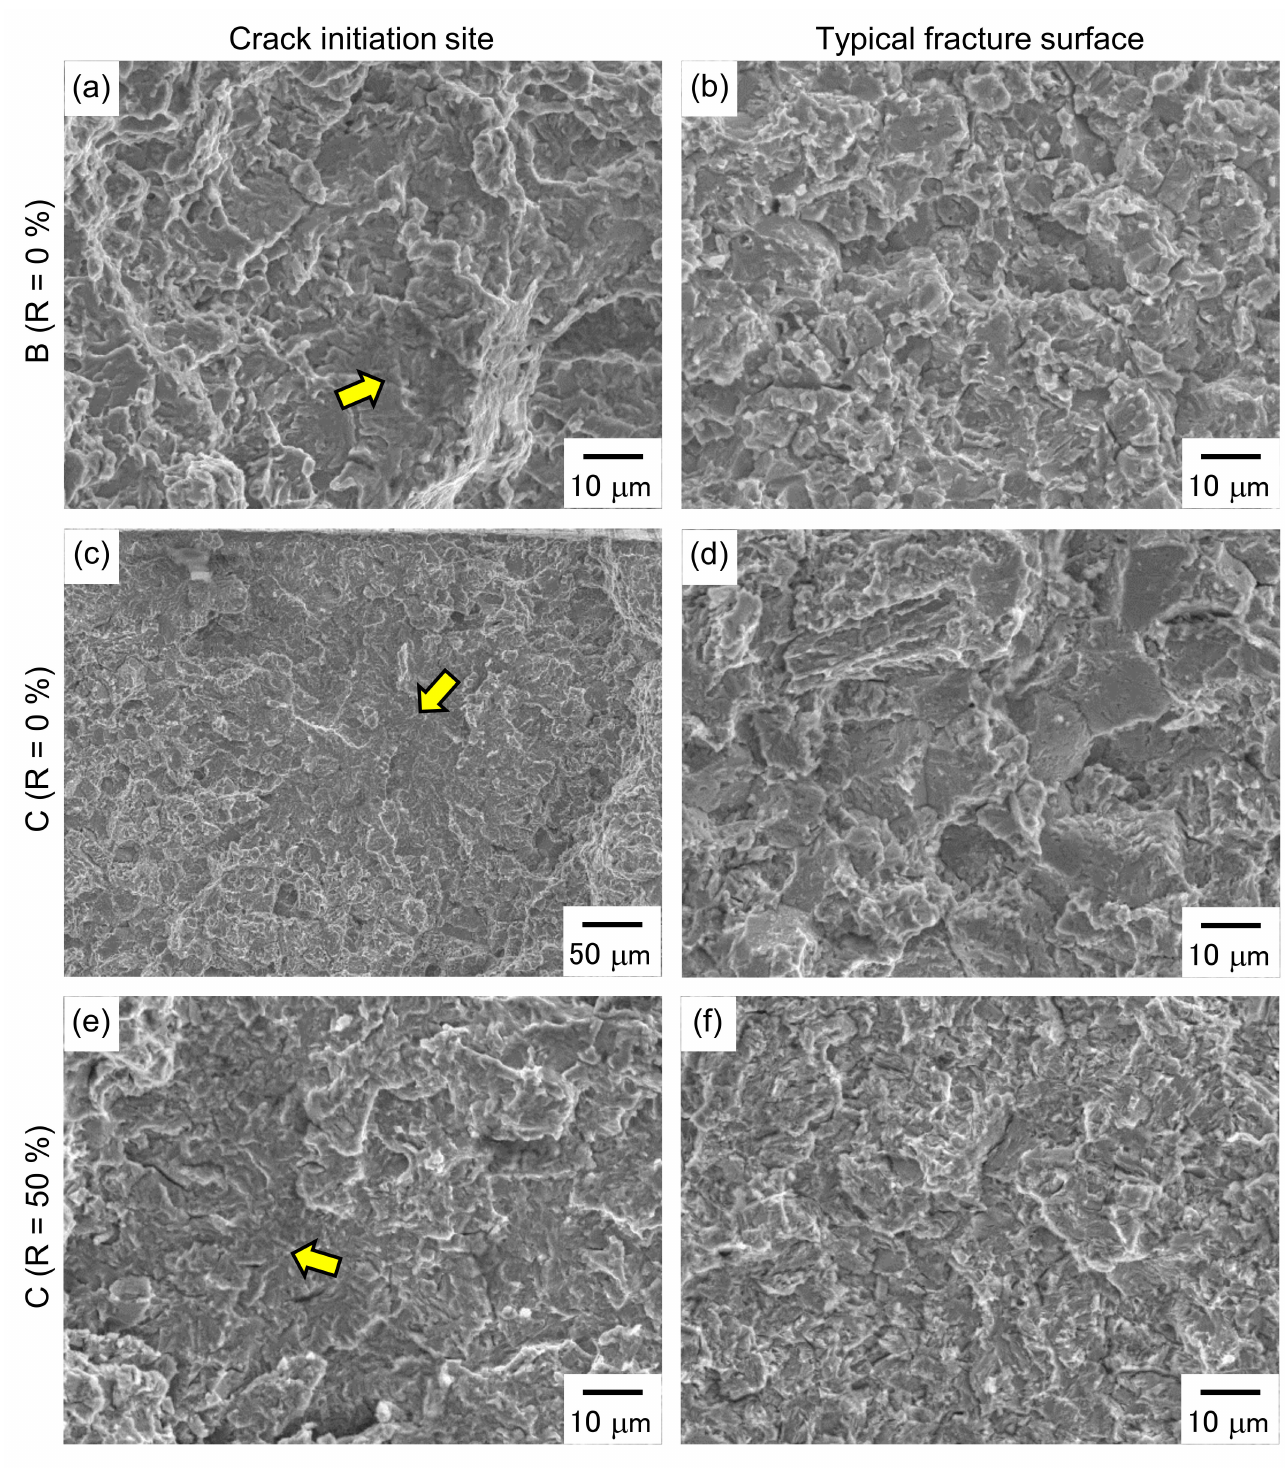
Figure 10. Fracture surfaces of ( a , b ) conventional steel B and ( c , d ) conventional and ( e , f ) hot-forged steel C after four-point bending tests, in which arrows represent crack initiation region. R represents reduction